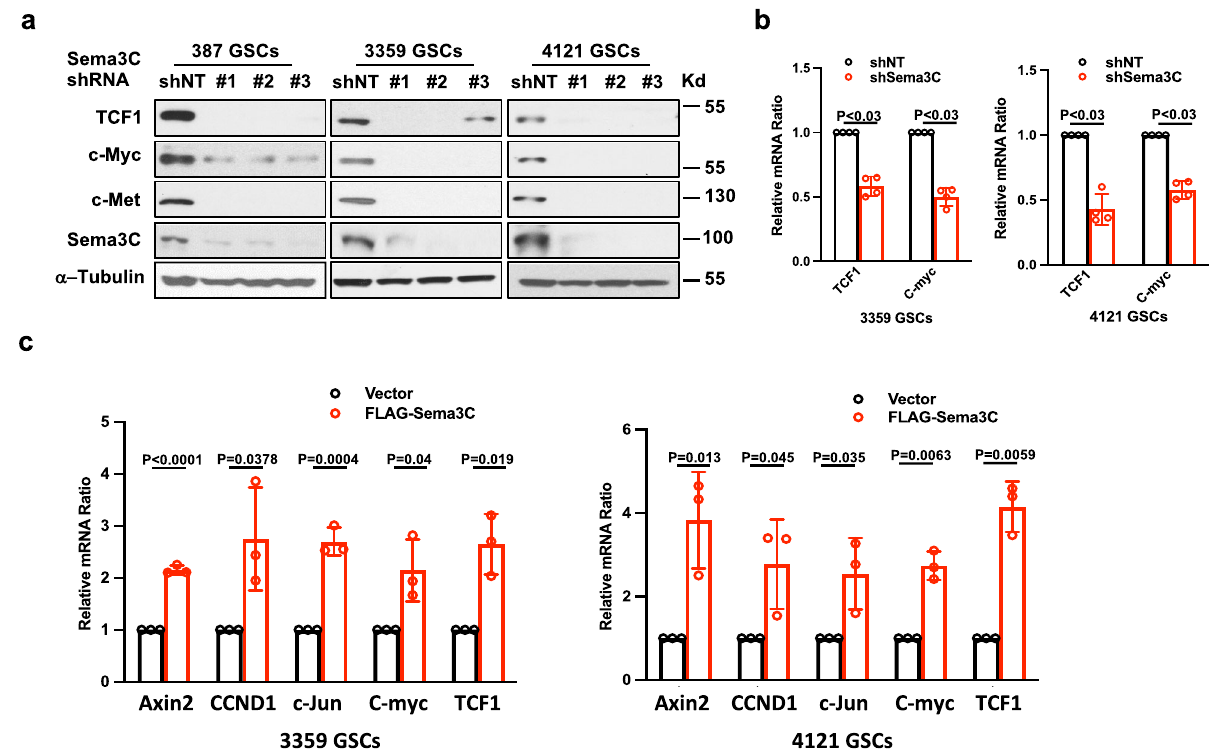
Fig. 3 | Sema3C regulates Wnt pathway. a Western blots of TCF1, c-Myc, and c-Met proteins after Sema3C knockdown. Western blots were repeated at least twice. b qRT-PCR of TCF1 and C-myc in 3359 and 4121 GSCs after Sema3C knock- down ( n =4 independent experiments, Mann Whitney U-test p <0.03, error bars: S.D.). c qRT-PCR of Axin2 (3359 GSCs p <0.0001; 4121 GSCs p =0.013),